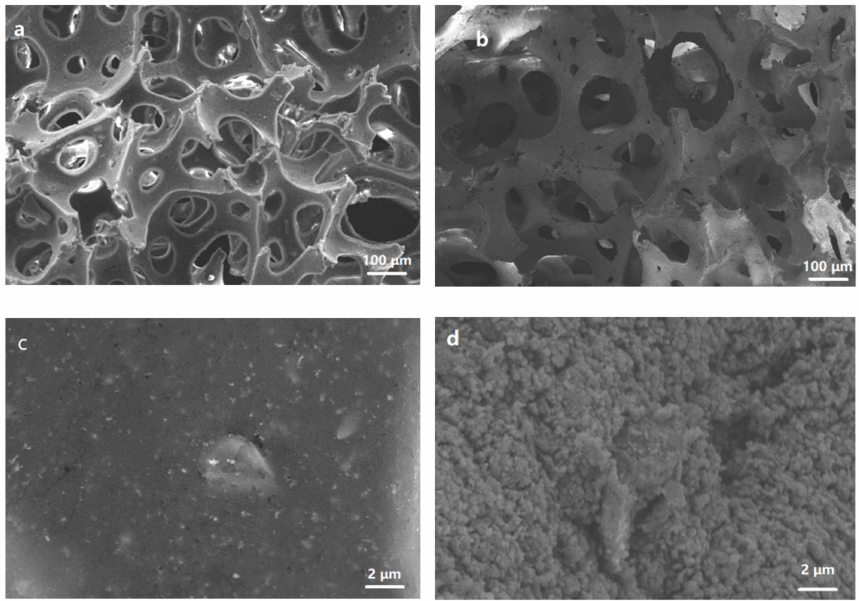
Figure 2. SEM photographs of NRS and PNRS (( a , c ): NRS; ( b , d ):